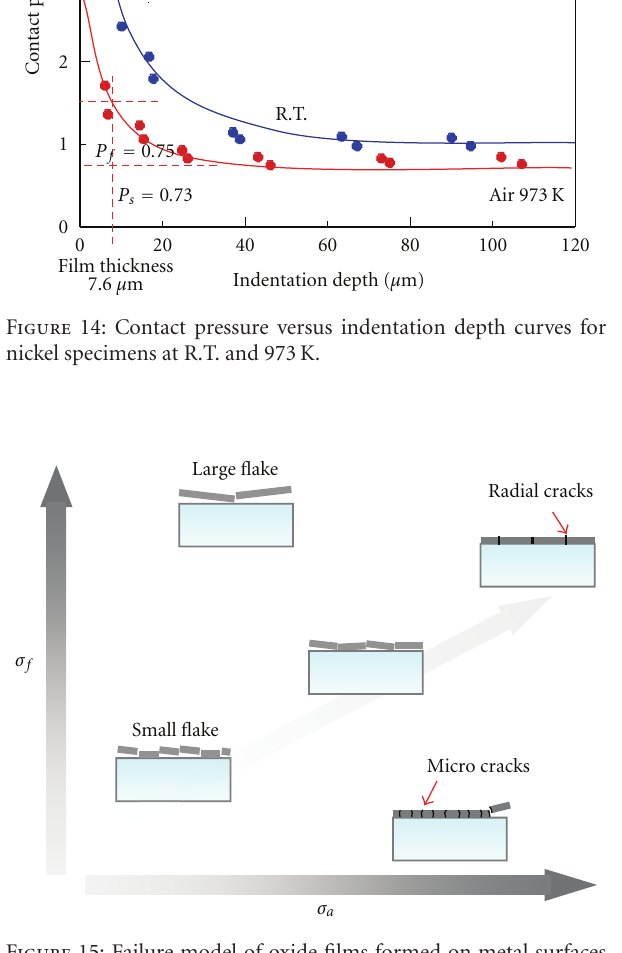
Figure 15: Failure model of oxide films formed on metal surfaces during dynamic indentation